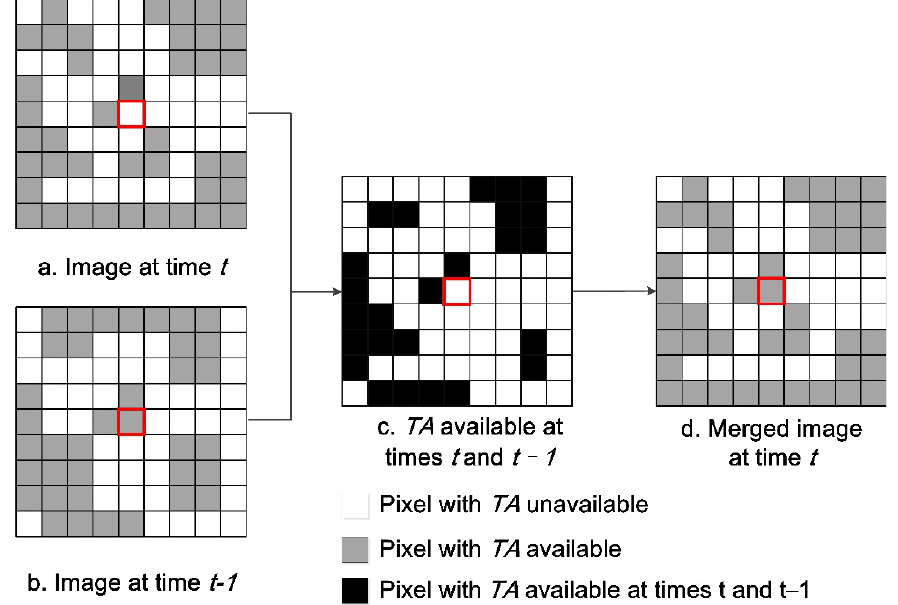
Figure 10. Flowchart for calculation of missing pixel values caused by cloud cover and other problems using the merged images from the day before the estimation date The red square represents the pixel for which TA will be calculated based on data from the previous